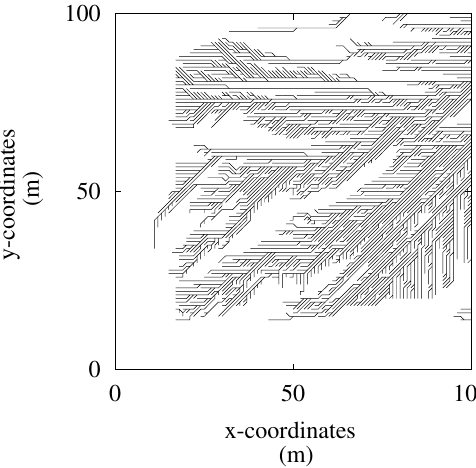
Figure 3. Part of the solution of Case 1, showing the density of the trails. Note that the calculated forwarding costs of parallel trails are almost equal, and a real forwarding operation would not use all of the plotted